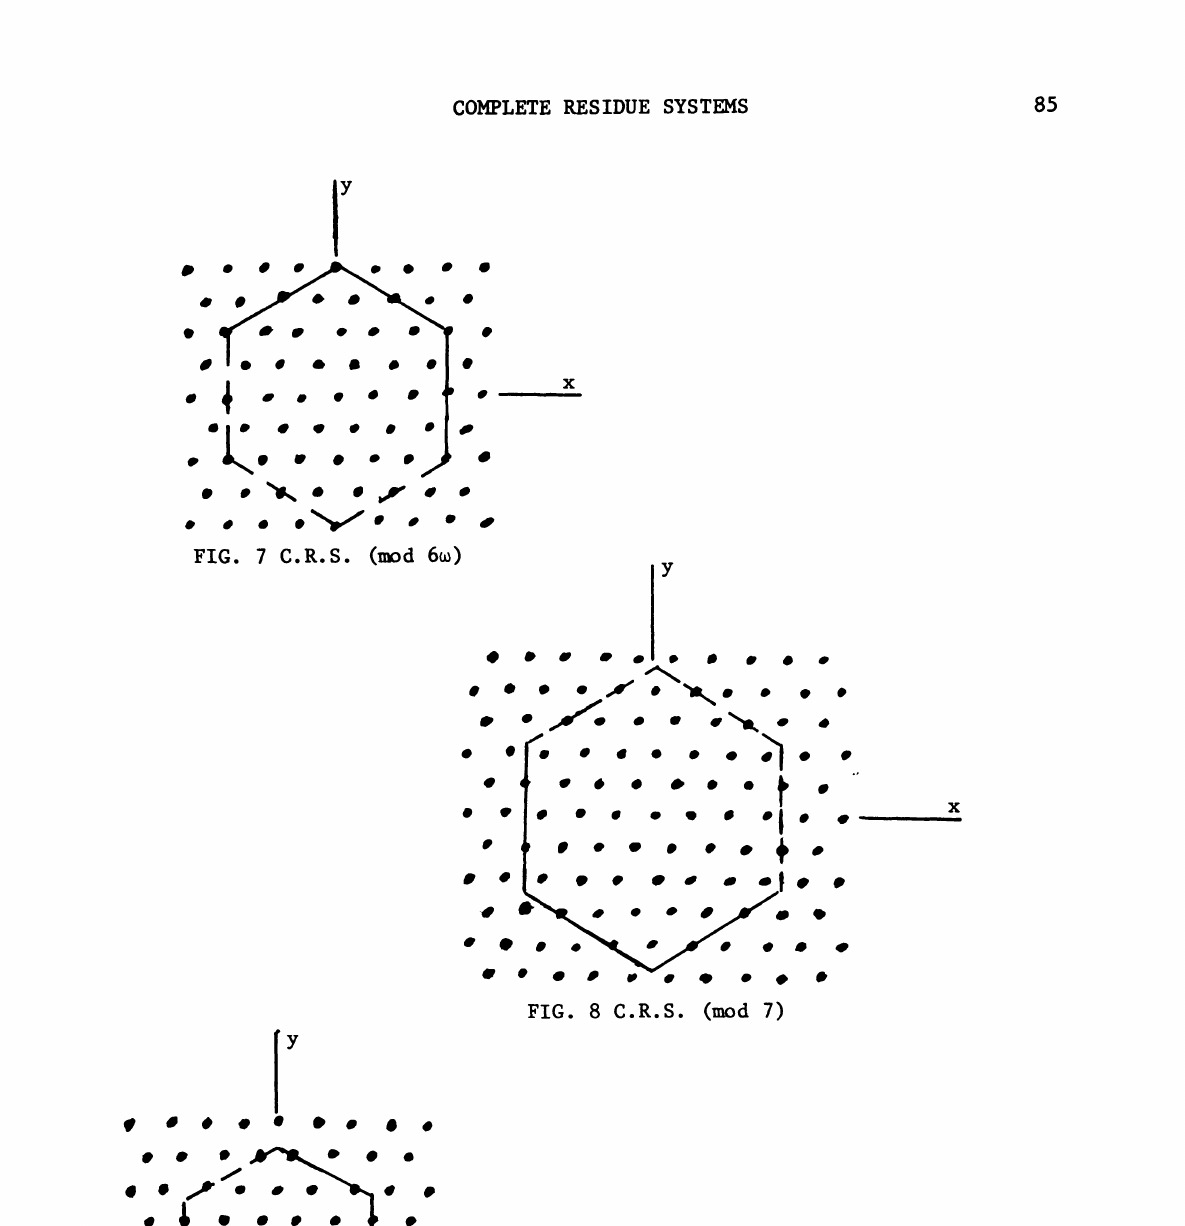
FIG. 8 C.R.S. (mod